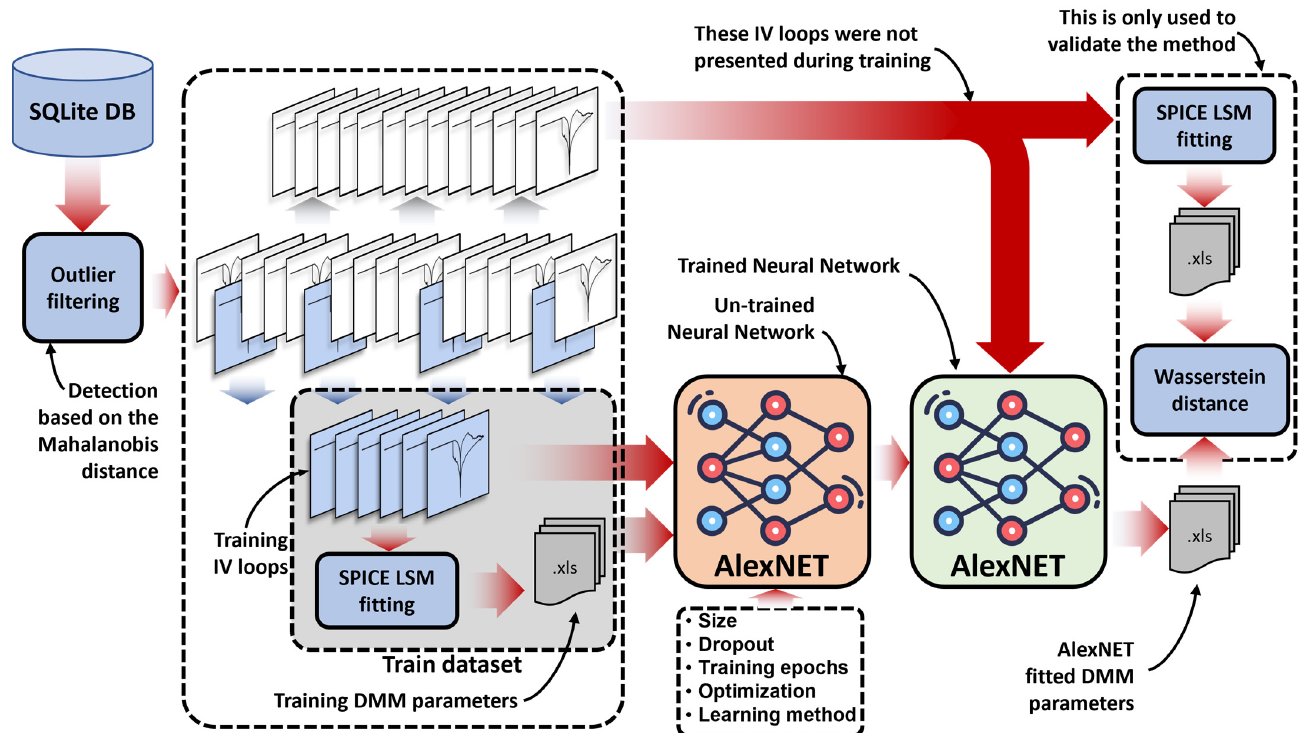
Figure 4. Flowchart of the proposed fitting procedure, including the training of the fitting network. The distribution of predicted values is analyzed in the following sections to discuss the fitting accuracy.